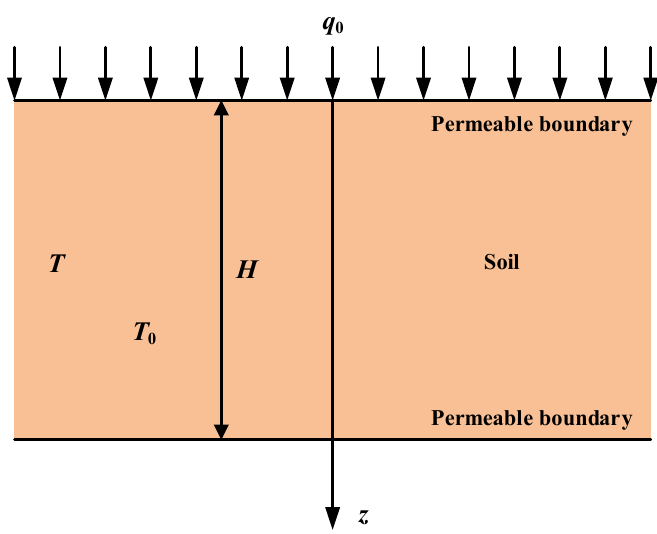
Figure 1. Schematic diagram of one-dimensional consolidation model.